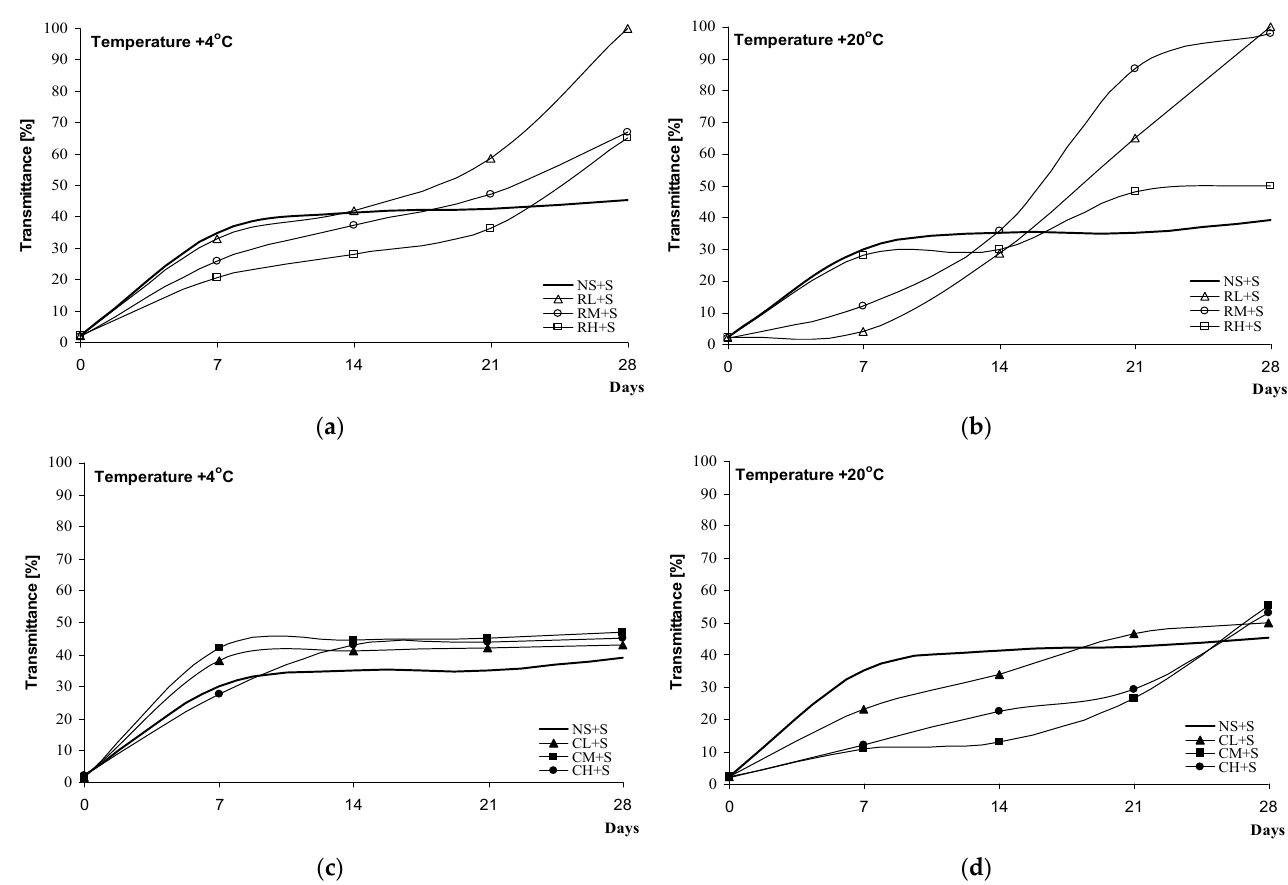
Figure 4. Retrogradation of black jelly-like desserts prepared on the basis of chemically ( a , b ) or physically ( c , d ) modified starches sweetened with sucrose.